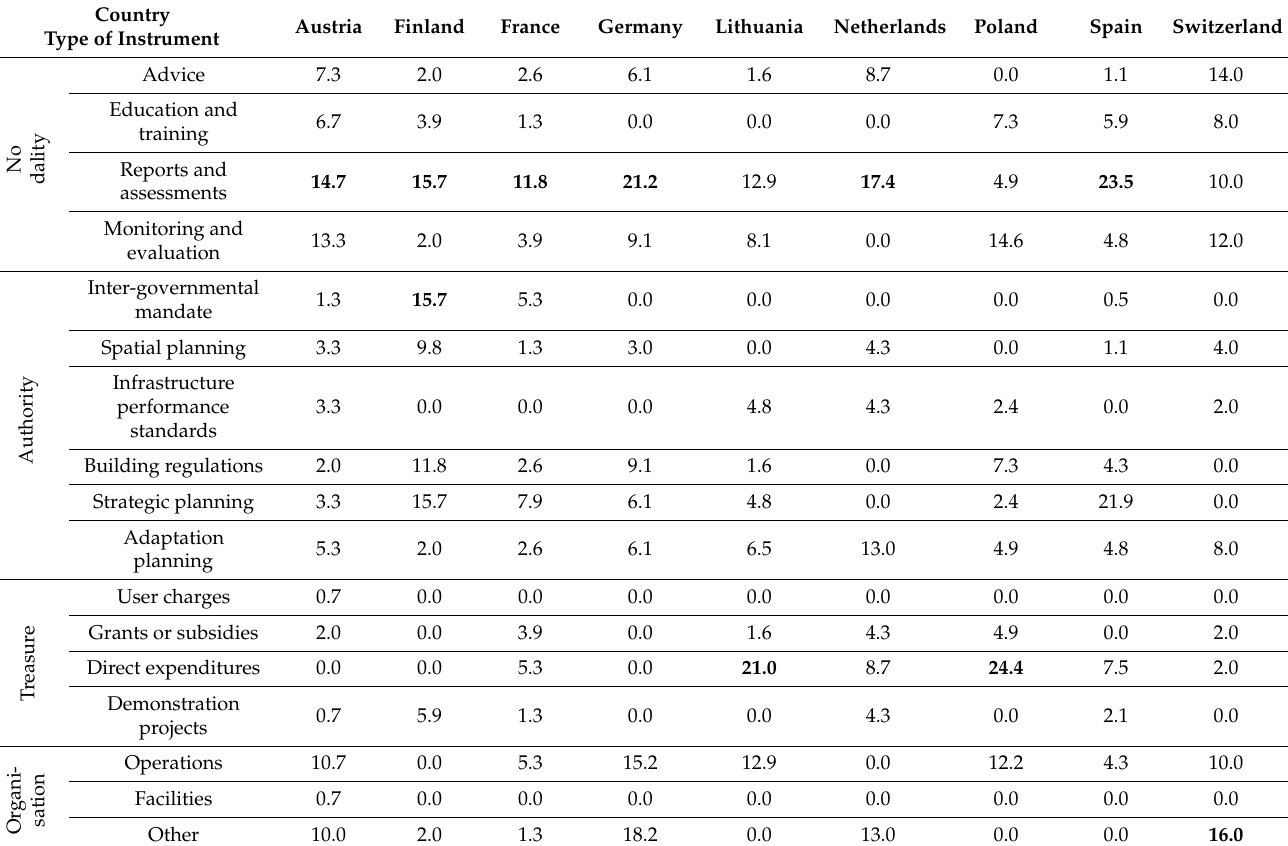
Table 4. Adaptation policy instruments grouped by NATO framework and instrument types